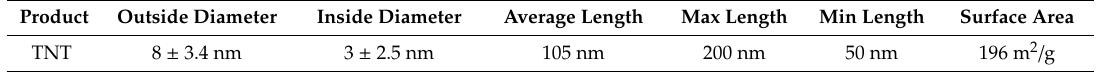
Figure 6. N 2 adsorption isotherm of hydrothermally synthesized TNT. Table 4. The size of TNT synthesized by the hydrothermal method.